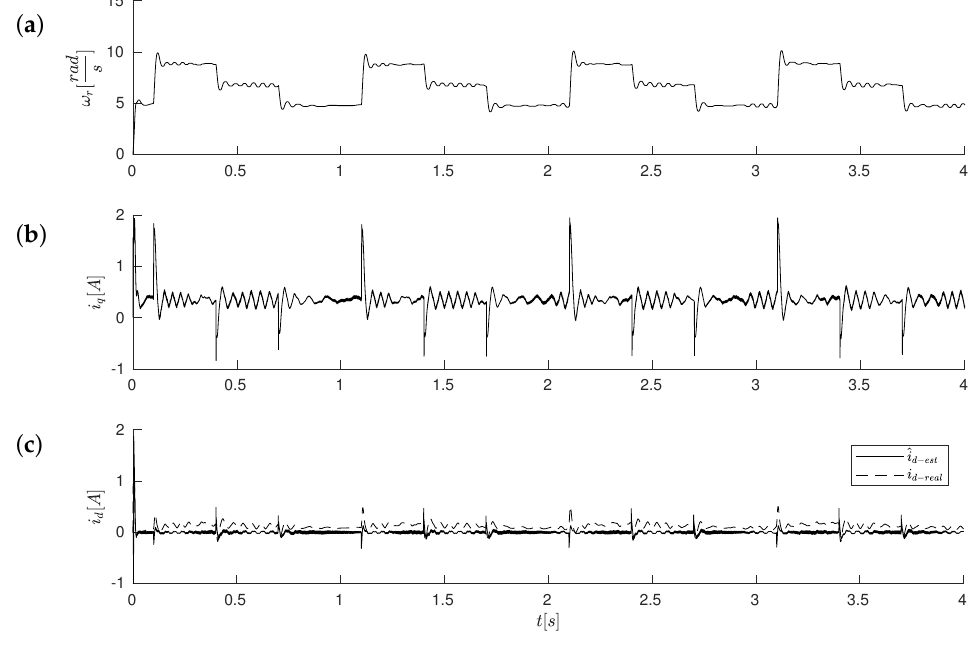
Figure 17. Simulation of low-speed control structure operation during speed changes ω ref = 8.8 ] , corresponding to the experiment shown in Figure 18. Values of motor speed ω r ( a ), 6.8 4.8 [ rad s → currents i q ( b ) and i d ( c ) respectively.